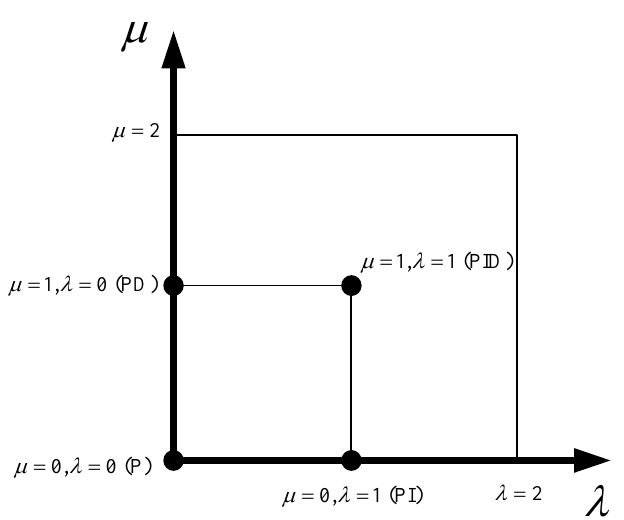
Figure 3. The converge of fractional order PID (FOPID) controller.